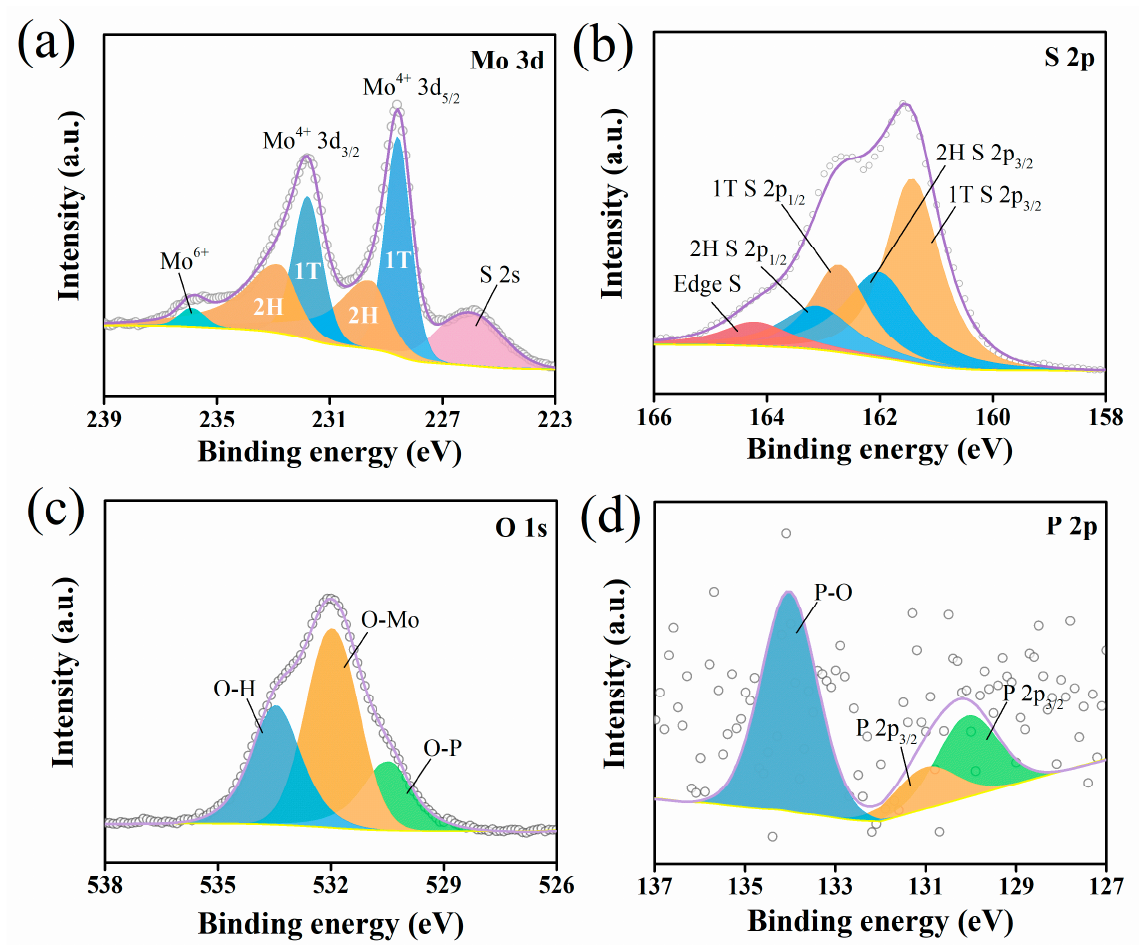
Figure 4. XPS spectra of P-MoS 2 : ( a ) Mo 3d, ( b ) S 2p, ( c ) O 1s, and ( d ) P 2p.